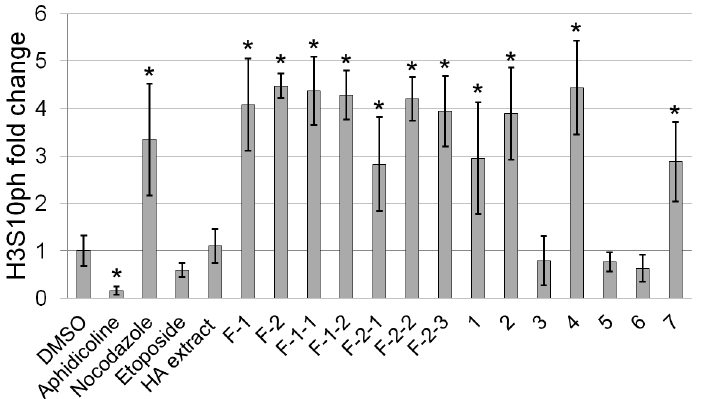
Figure 2. Staining of mitotic nuclei by phospho-histone H3 (H3S10ph) in zebrafish embryos treated with the hydrocoholic extract fractions and the pure compounds: Podophyllotoxin ( 1 ), β -peltatin-A-methylether ( 2 ), 5 ′ -desmethoxy- β -peltatin-A-methylether ( 3 ), desmethoxy-yatein ( 4 ), desoxypodophyllotoxin ( 5 ), burseranin ( 6 ), and acetyl podophyllotoxin ( 7 ). The fold changes were determined in comparison with the control (DMSO-treated). Values represent means ± s.d. * Significant differences ( p < 0.001). These results are also shown in Table S1.